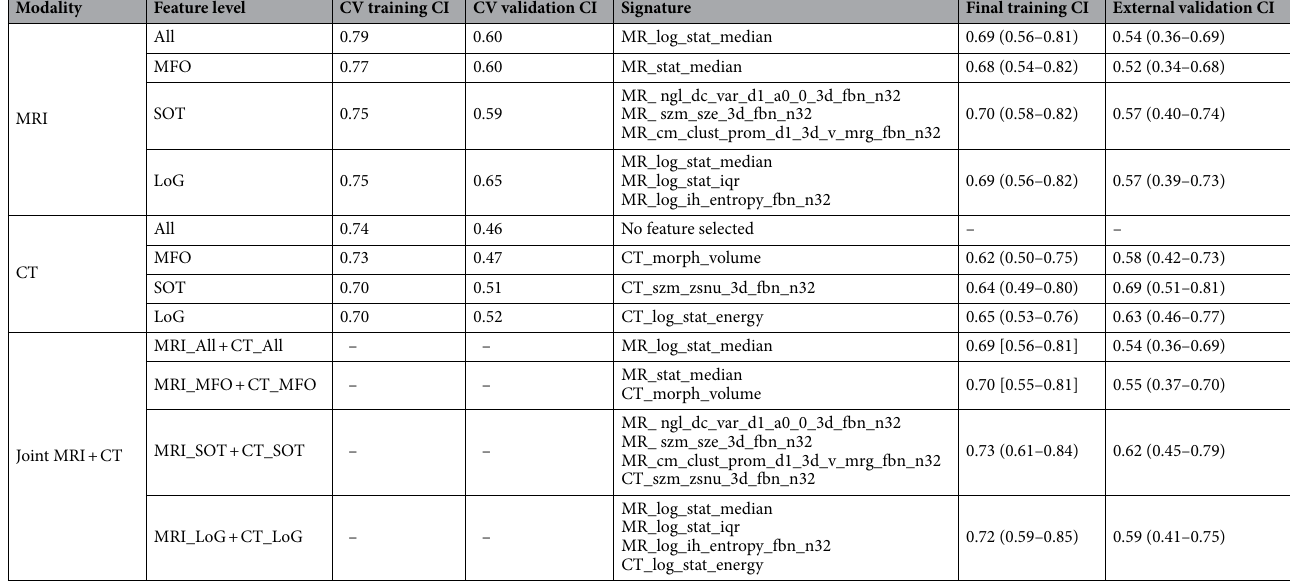
Table 3. Median concordance index (CI) values for cross-validation (CV) and external validation for FFDM prediction in MRI, CT, and joint MRI + CT. Values in parenthesis represent the 95% confidence interval. CI concordance-index, CT computed tomography, CV cross-validation, LOG Laplacian of Gaussian, MRI magnetic resonance imaging, MFO morphological and first order, SOT second order